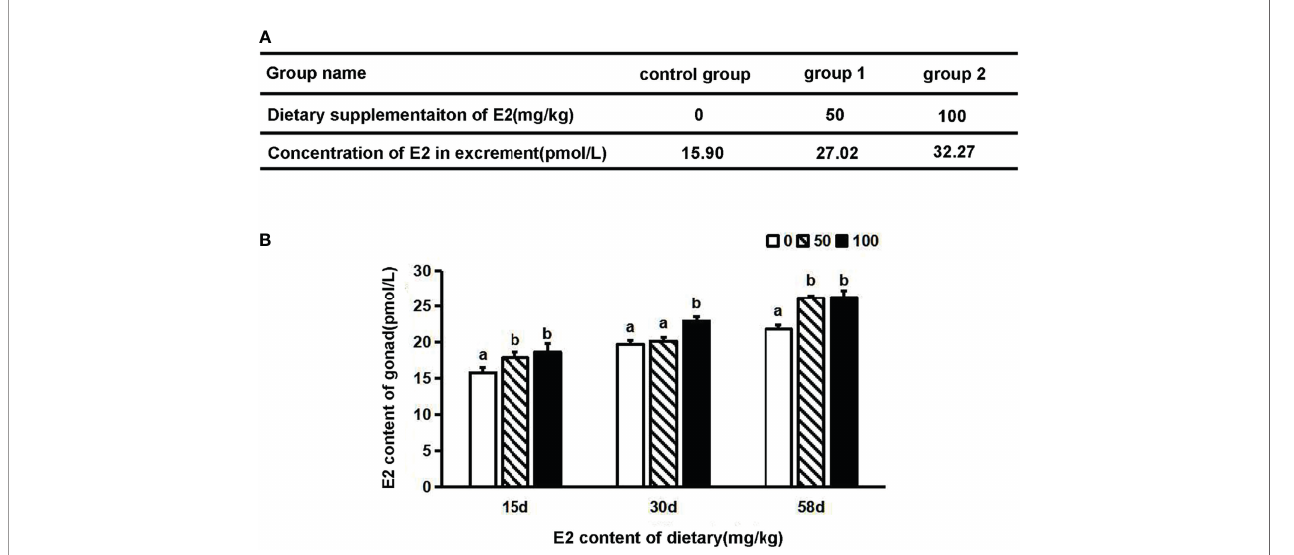
FIGURE 5 | The concentration of estradiol levels in S. intermedius . (A) Concentration of estradiol in excrement after 3 days of dietary supplementation of E2. (B) Concentration of estradiol in testis on different days after dietary supplementation of E2 ( n = 6). E2, estradiol; d, day. One-way ANOVA was used to determine statistical analysis. Different letters indicate signi fi cant differences ( p ≤ 0.05).